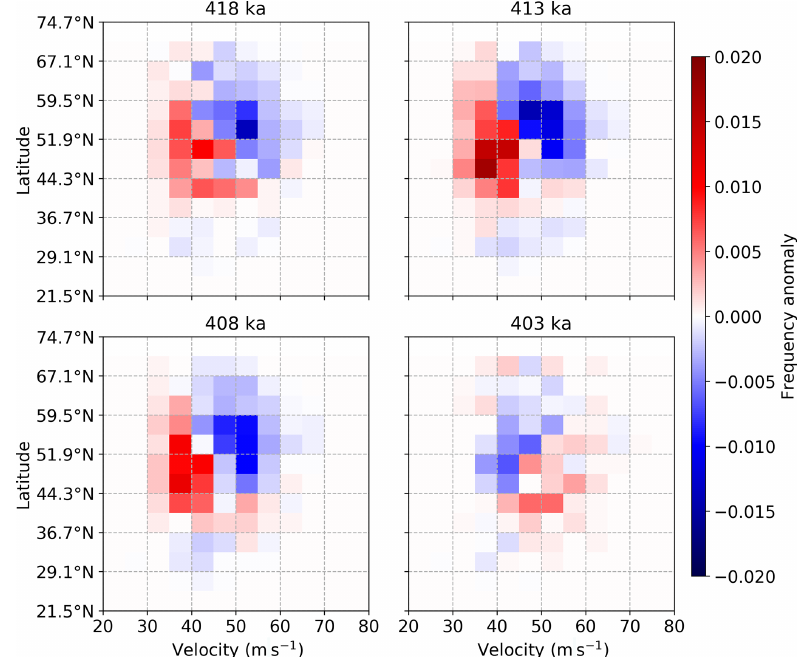
Figure 5. Changes in the frequency of the latitude and peak velocity of JJA daily maximum 300hPa winds over the North Atlantic for the core MIS-11 interglacial period of 418–403ka. Latitude bins are approximately 3.8 ◦ , containing two model grid cells each. Velocity bins are at intervals of 5ms − 1 . Frequency matrices are computed relative to the preindustrial control simulation, and the velocity maxima reflect the maximum single value at any grid point in the analysis domain.